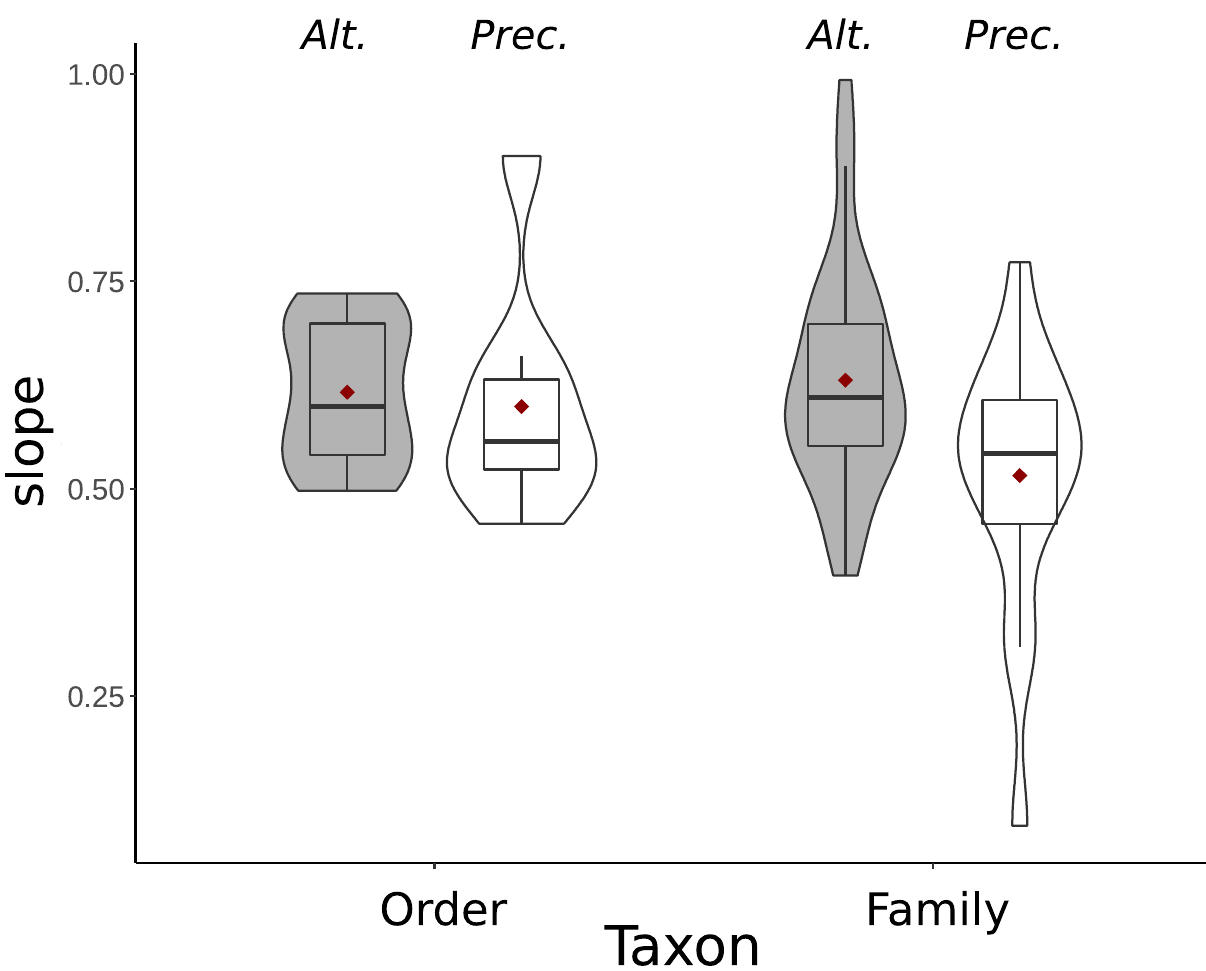
Fig 5. Brain–body allometries among altricial and precocial birds. Violin plots of slopes of the brain–body allometries of altricial (gray bars) and precocial (white bars) orders and families of birds. Data are taken from [104]. Orders or families were included when > 5 species were available. Horizontal bars represent the median, red diamonds the mean, and boxes enclose the central 50% percentile range. The difference at the family level is significant (t = 2.60, DF = 26.46, p < 0.02). Sample sizes for altricial birds: 15 orders and 38 families; for precocial birds: 8 orders and 17